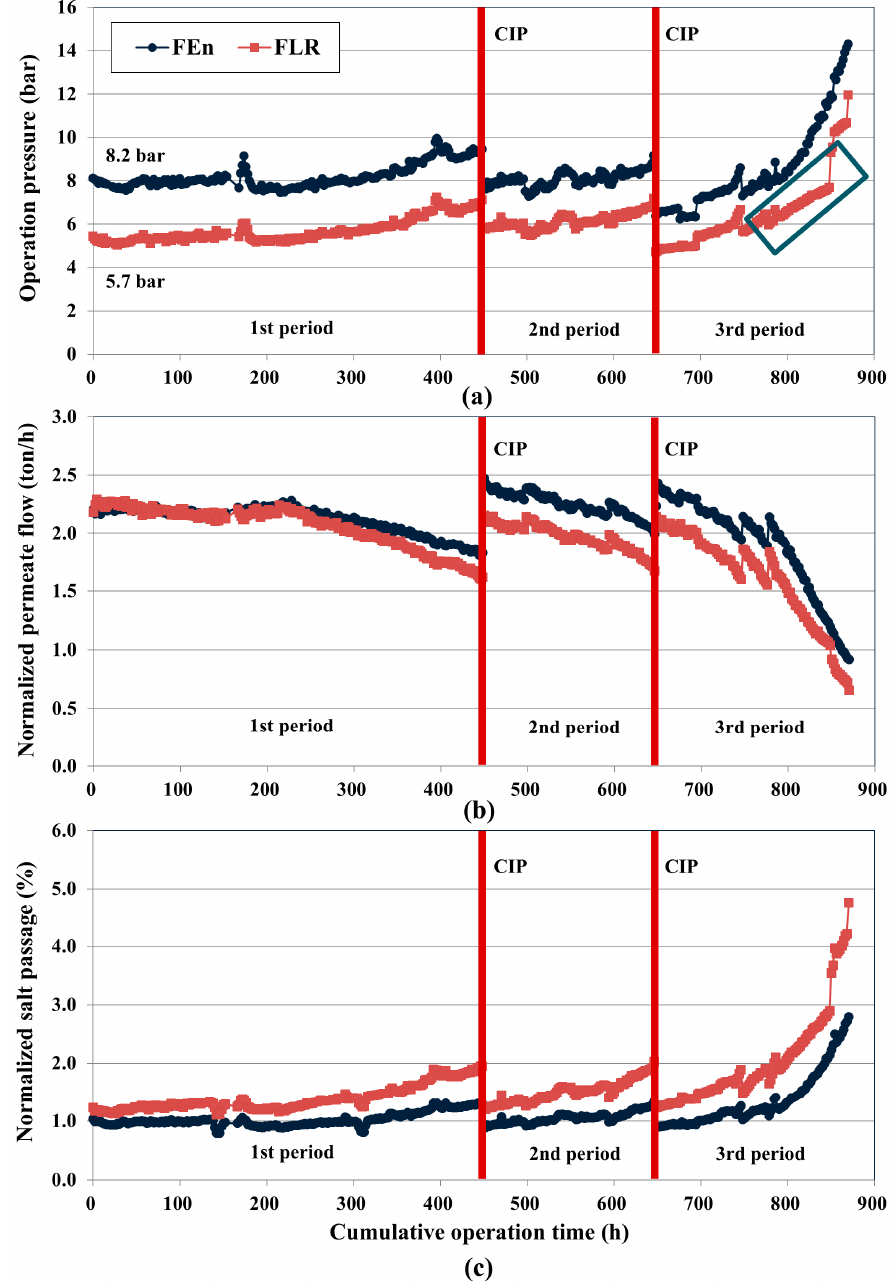
Figure 6. Performance variations monitoring of the pilot RO system: ( a ) Operating pressure variations of the FEn and FLR; ( b ) Normalized permeate flow (NPF) variations of the FEn and FLR; ( c ) Normalized salt passage (NSP) variations of the FEn and FLR.